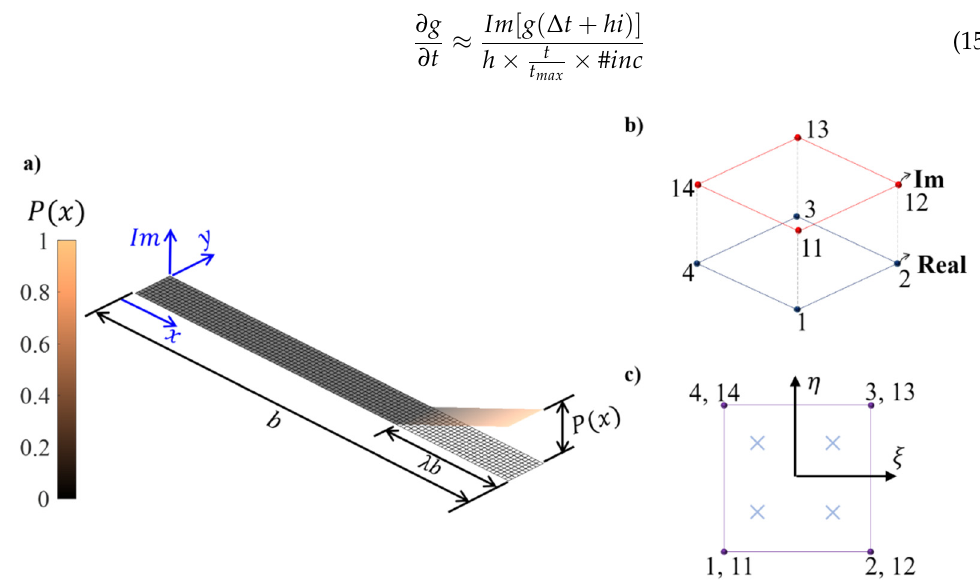
Figure 2. ( a ) Mesh perturbation function P ( x ) for nodal coordinates required for geometrical sensitivities using Transient Thermal ZFEM, where p represents a fraction of the mesh that was perturbed. ( b ) Duplicated node approach for the CR representation for a 2D finite element. ( c ) Detail of the local coordinate system and quadrature points for the 4 real 4 imaginary nodes 2D element.